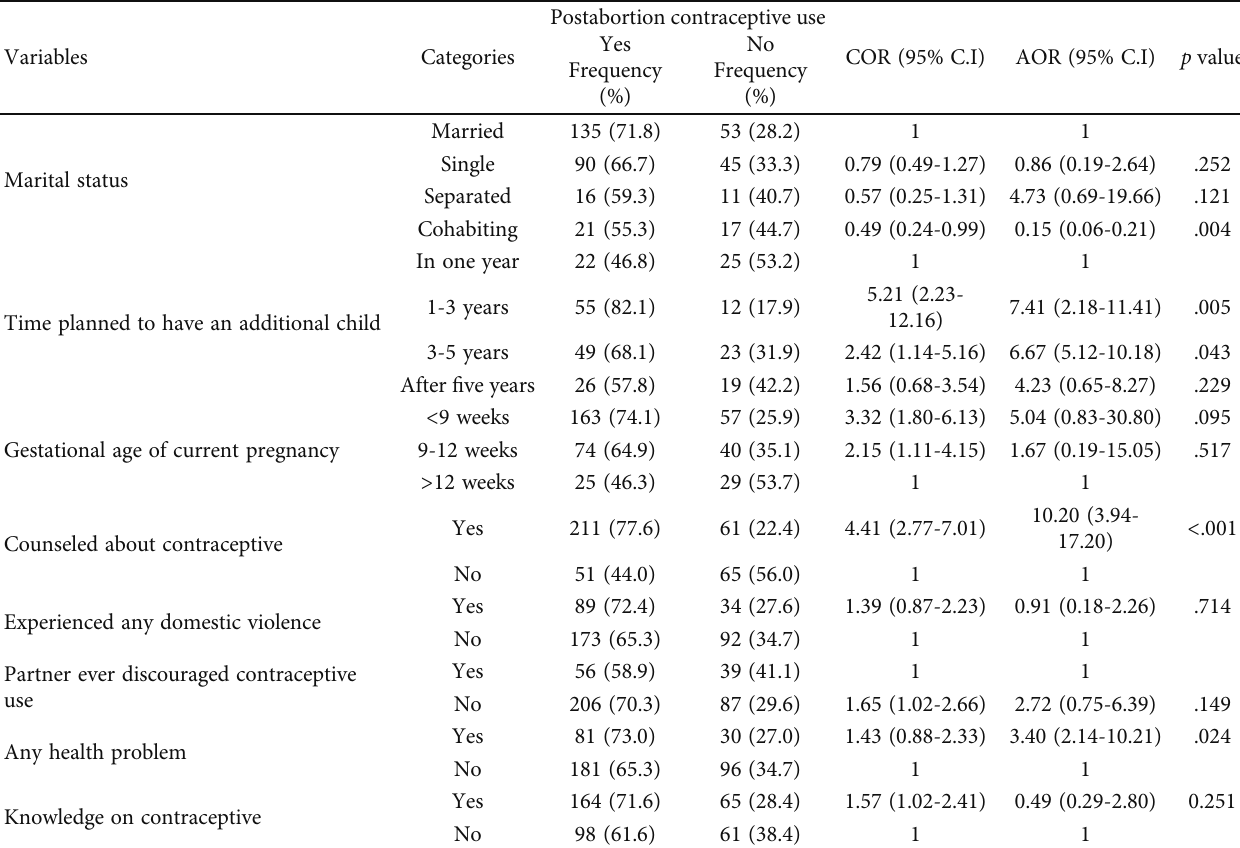
Table 3: Bivariate and multivariate logistic regression for the factors associated with postabortion contraceptive utilization among women who received abortion care services at health facilities in Ambo town, Oromia region, Ethiopia,